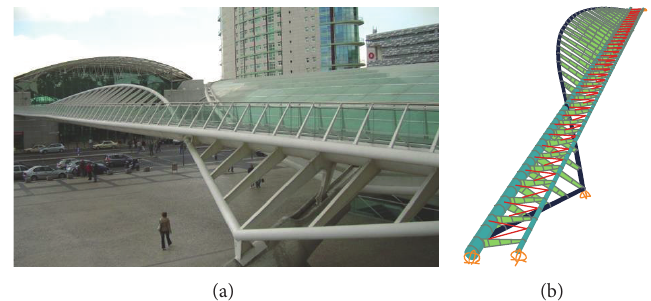
Figure 15: (a) Vision of the CC Vasco da Gama (Calatrava) structure; and (b) analytical model.